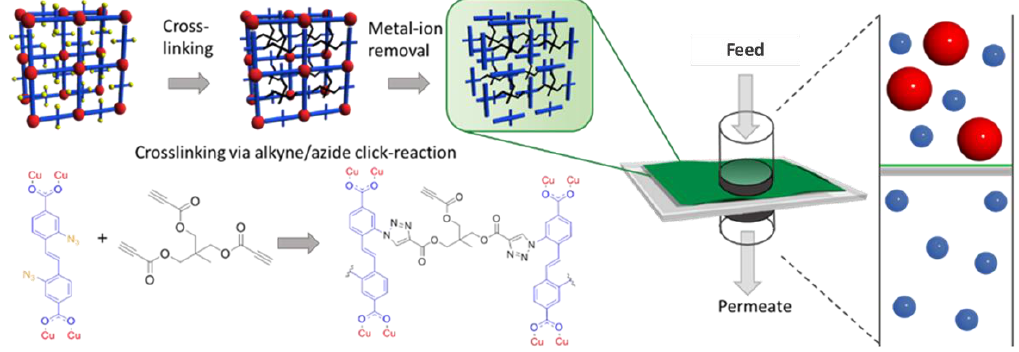
Figure 1. Synthesis of the SURGEL via crosslinking the azide functionalities within the SURMOF structure with a multitopic alkyne cross-linker.